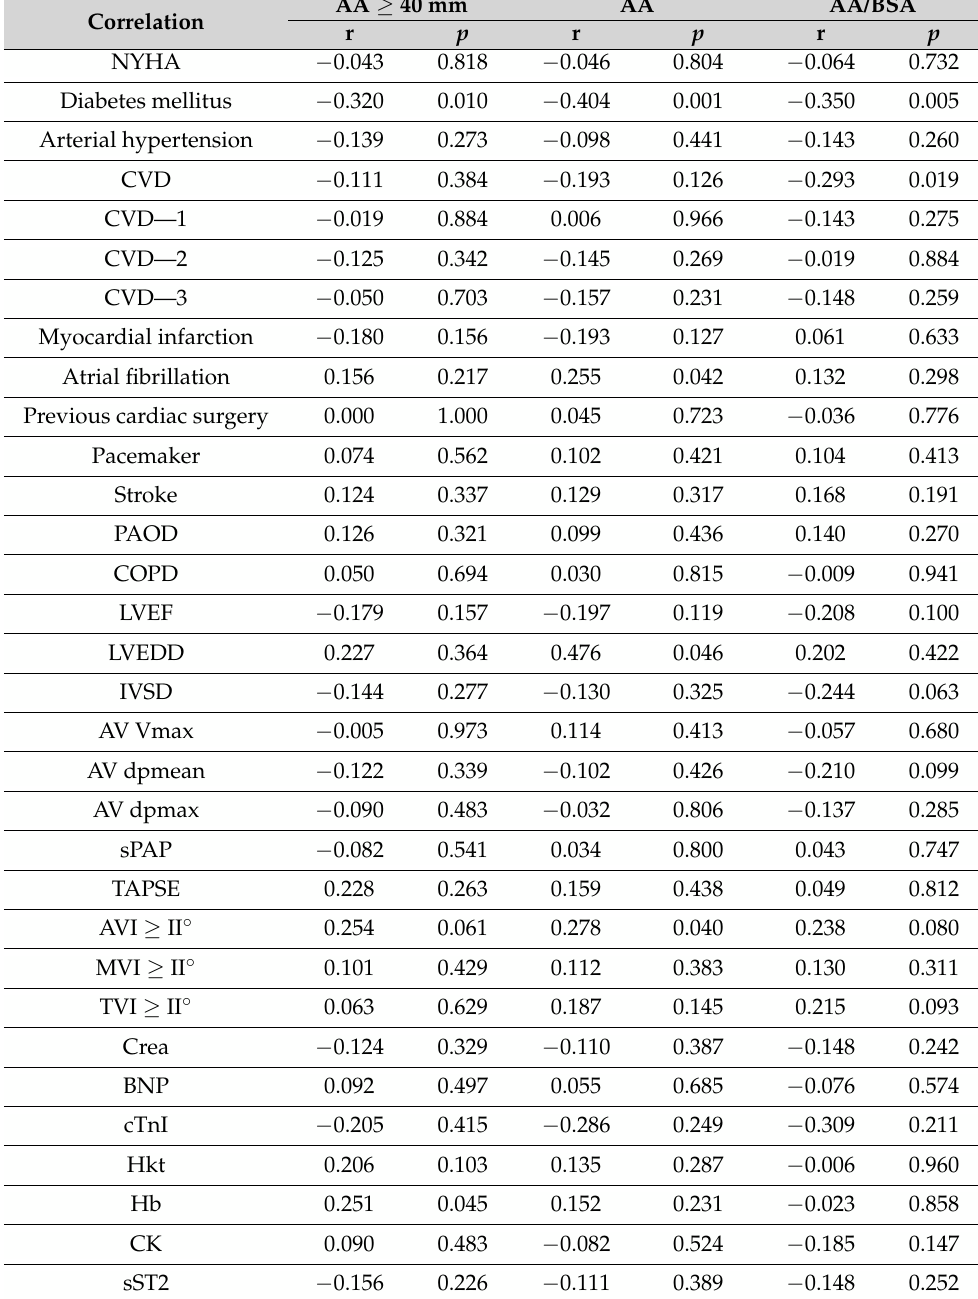
Table 2. Tabular overview of correlation analysis (Pearson’s or Spearman’s) between AA ≥ 40 mm, AA diameter, AA/BSA ratio and various clinical